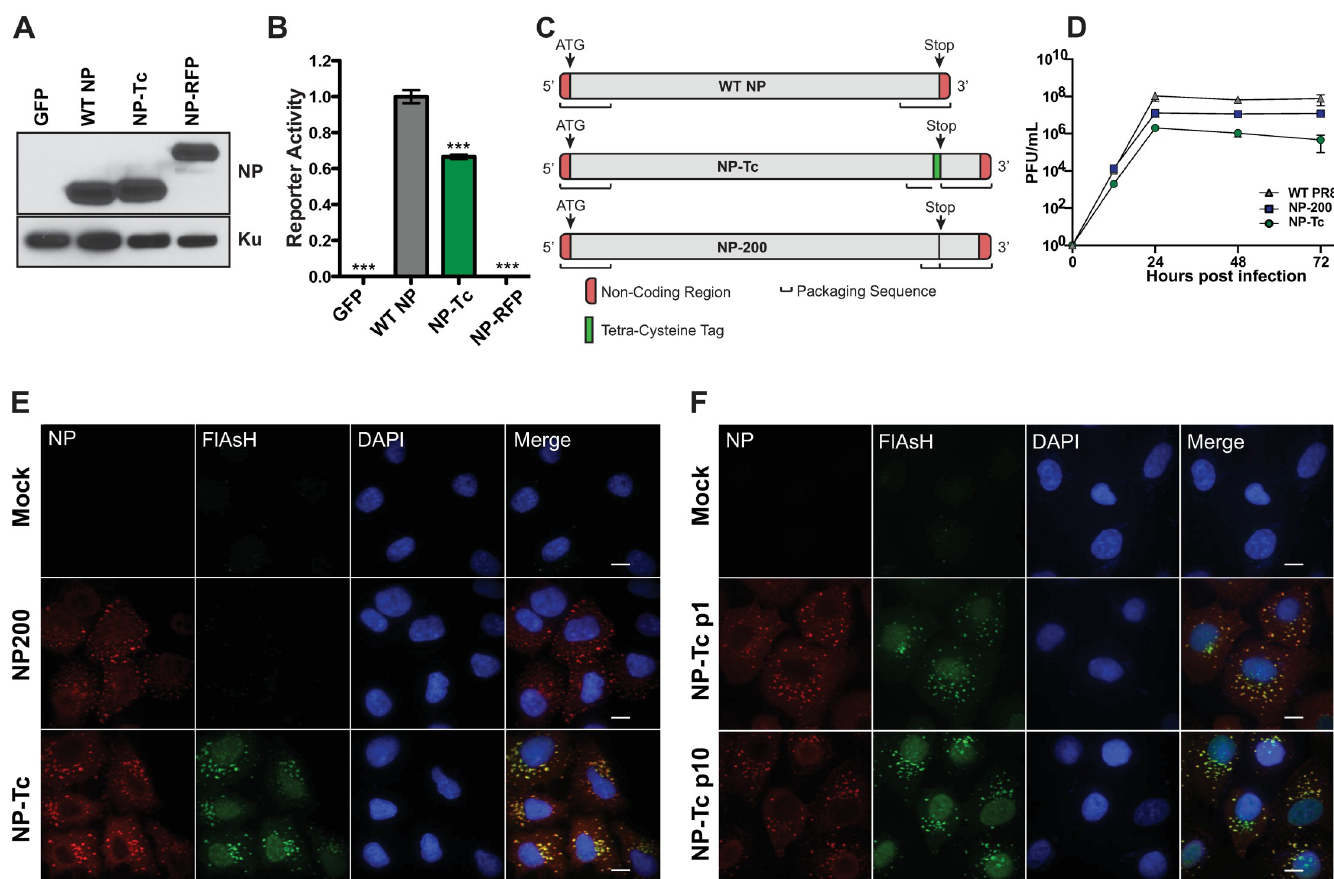
Fig 1. Design and characterization of Tc-tagged NP virus. (A) Western blot analysis of fluorescently tagged NP. HEK293T cells were transfected with different NP constructs and cell lysates were prepared at 48h post-transfection. Western blot analysis was performed using anti-NP antibody and Ku antigen is shown as a loading control. (B) Mini-genome activity of fluorescently tagged NP. HEK293T cells were transfected with plasmids expressing PB1, PB2, and PA of H1N1 (A/WSN/1933) along with WT NP or fluorescently tagged NP constructs and a firefly luciferase vRNA reporter. Transfection efficiency was normalized using an SV40-renilla reporter. Data are represented as mean reporter activity relative to WT NP (n = 6 per condition ± SD). (C) Schematics of modified NP segments. WT NP segment contains packaging sequences at both 5’ and 3’ termini. As the insertion of a Tc tag disrupts the 3’ packaging sequence, the 3’ packaging sequence (200 nucleotides) was duplicated after the stop codon. Schematics not to scale. (D) Comparison of growth kinetics for WT PR8, NP200 and NP-Tc viruses. MDCK cells were infected with WT PR8 or NP-Tc virus at MOI = 0.01 and viral titers were measured at the indicated time points by plaque assay. Limit of detection = 10 PFU. Data are represented as mean titers of triplicate samples ± SD. (E) NP-Tc FlAsH stain co-localizes with NP antibody staining. A549 cells were infected with NP-Tc or NP200 virus at MOI = 1 for 9 hours and stained with FlAsH dye and anti-NP antibody. Scale bar = 10 μ m. (F) Tc tag remains stable in NP-Tc virus after 10 passages. NP-Tc virus was blindly passaged in MDCK cells 10 times. After passage 10 (p10), individual plaques were purified and amplified in embryonated eggs. A549 cells were infected with virus from passages 1 and 10 at MOI = 1 for 7 hours and stained with FIAsH dye and anti-NP antibody. Scale bar = 10 μ m. � p-value < 0.05; �� p-value < 0.01; ��� p-value < 0.001; ns, non-significant. Data are representative of at least three independent